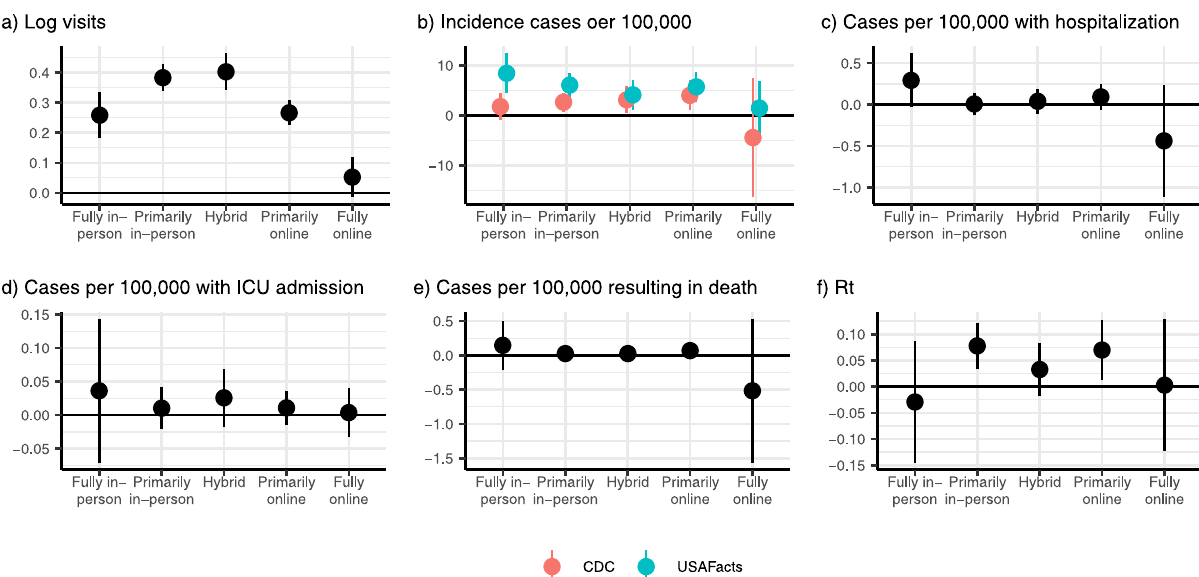
Fig 3. Differential effects of reopening college campuses by expanded teaching modality. (a) Campuses that reopened for “Primarily in-person” and “Hybrid” teaching had the largest increase in devices on campus following reopening, while the increase in visitors was significantly smaller for fully online reopenings ( χ 2 (4) = 331.80, p < 0.001). All reopenings except “Fully Online” were associated with a significant increase in COVID-19 cases after reopening (b) using incidence data from USAFacts ( χ 2 (4) = 14.20, p = 0.007). There were no statistically significant adverse effects of reopening